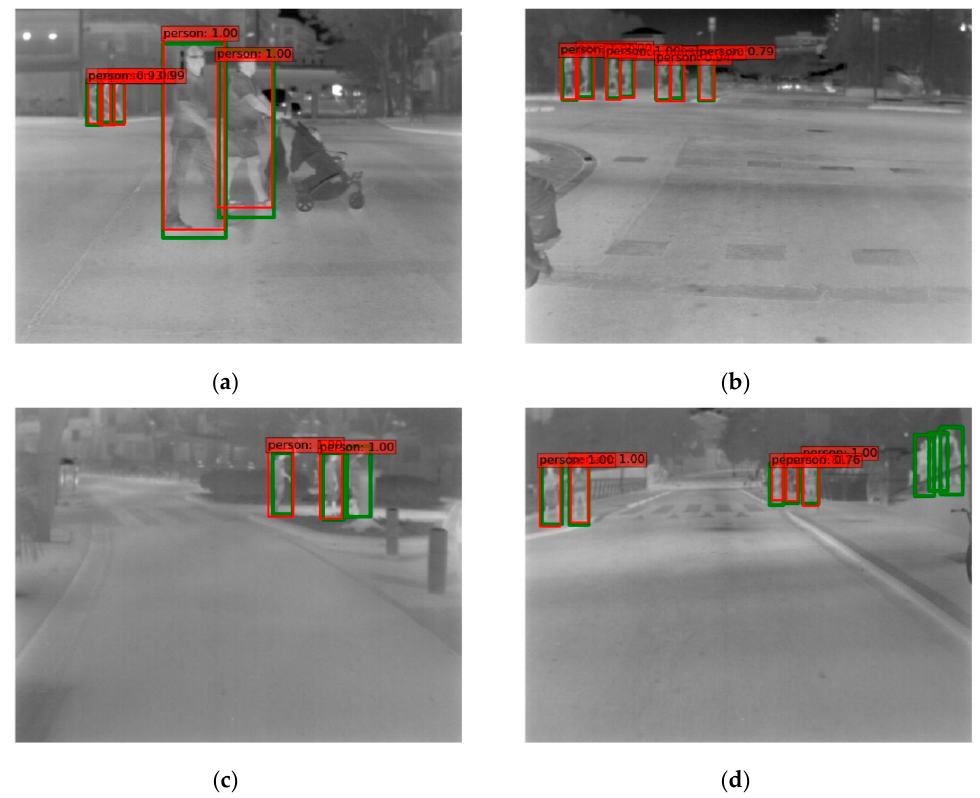
Figure 8. Four detection results of the CVC09 test dataset. The green bounding boxes denote the ground truth, and the red bounding boxes show the detection results. ( a–d ) are visualization of detection results on the image set selected from the dataset.